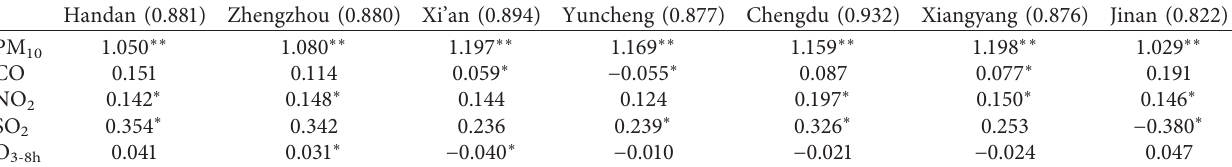
Table 5: Statistical results of MGWR model between PM